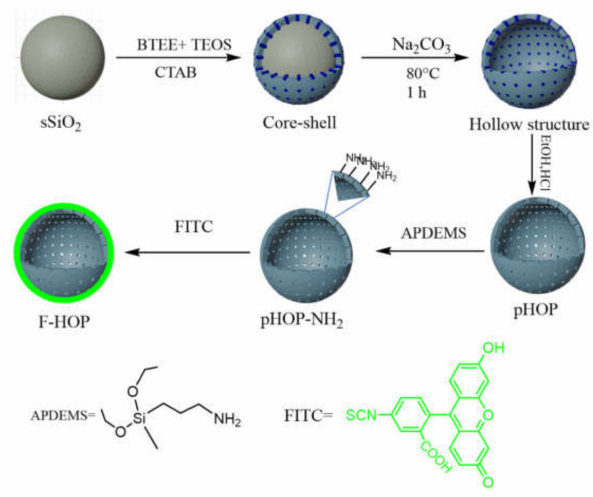
Figure 1. Schematic representation for the preparation of amino-modified pHOPs and F-HOPs.